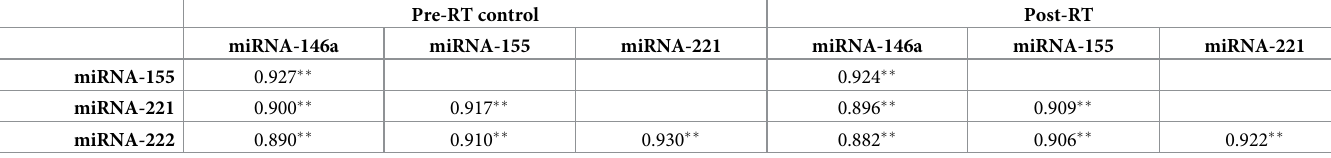
Table 2. Correlations between expression of selected miRNAs in blood of BC patients at pre-RT control and post-RT. Pre-RT